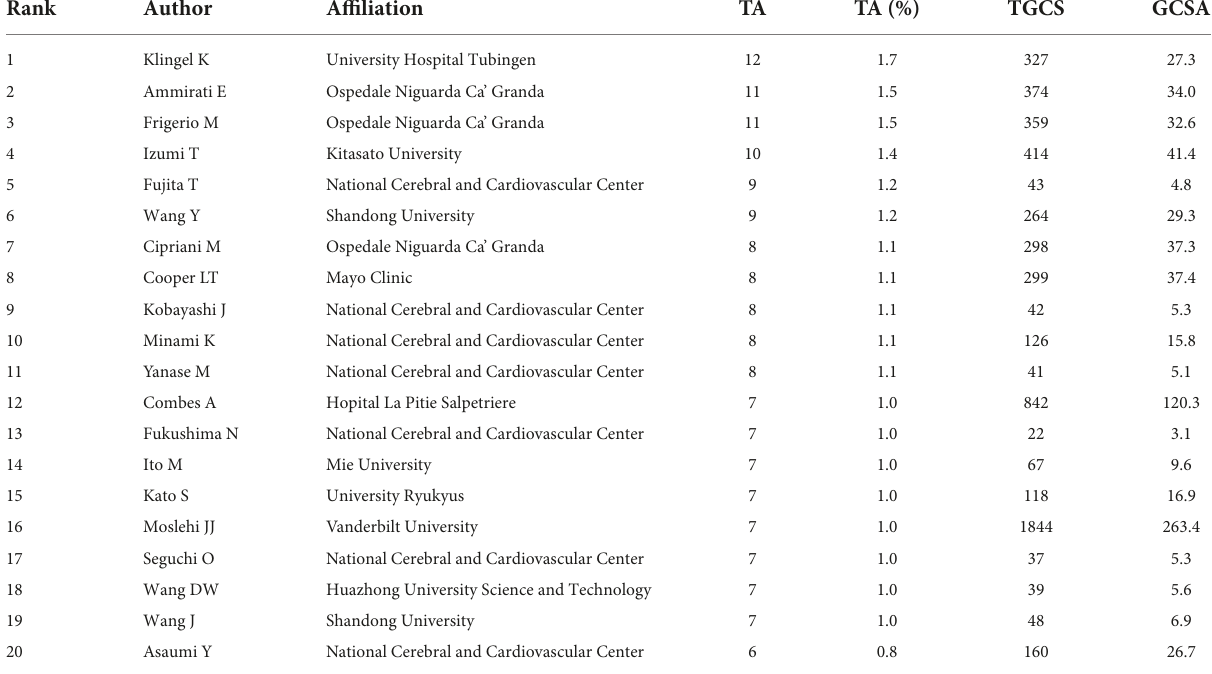
TABLE 4 Top 20 contributing authors in terms of